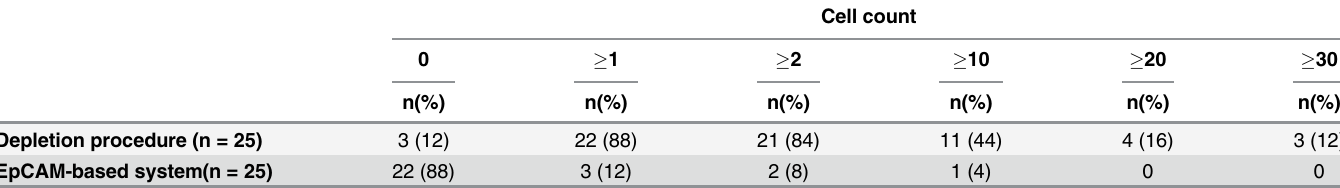
(Table 2). Of the two CTC positive cases detected by the EpCAM-based system, one had 11 CTCs/7.5 mL and the other four CTCs/7.5 mL peripheral blood and both cases resulted posi- tive by depletion procedure having 13 and 14 SCEs/5 mL blood, respectively. Table 2. Comparison between depletion procedure and EpCAM-based enrichment system in 25 advanced SQCLC